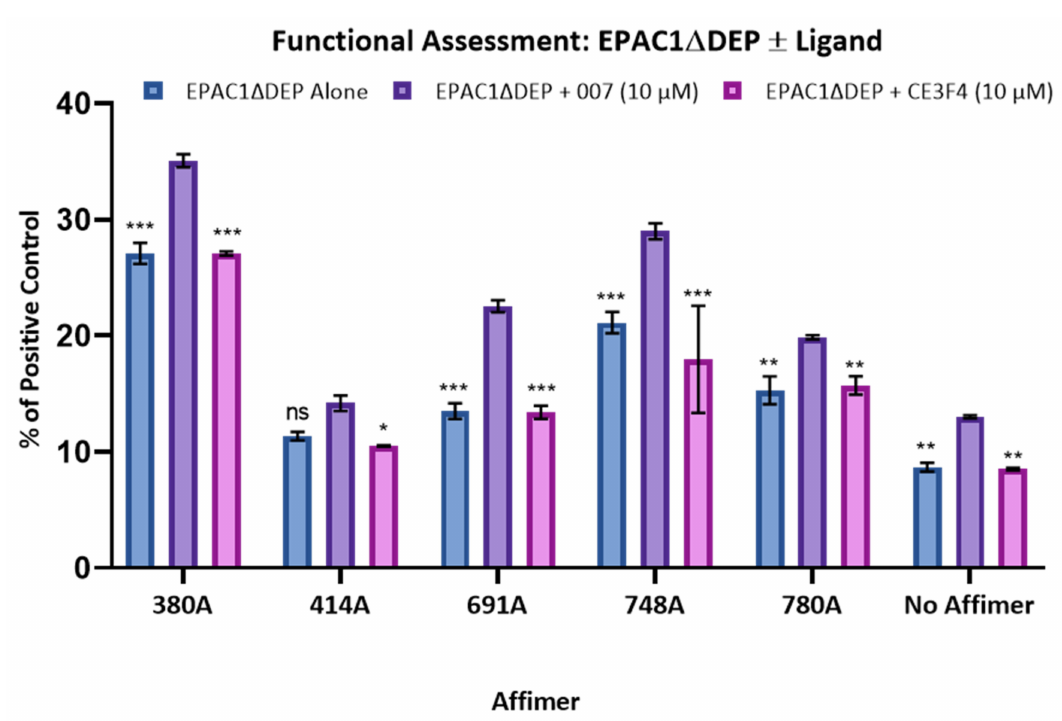
Figure 2. Assessment of Affimers binding to EPAC1 ∆ DEP in the presence or absence of agonist and antagonist. Affimer binding to biotinylated EPAC1 ∆ DEP protein was determined by iQue assay, in the presence and absence of 10 µ M 007 (EPAC1 agonist) or 10 µ M CE3F4 (EPAC1 antagonist). Data were normalized to the median fluorescent intensity of the positive control Affimer (Affimer G12 against immobilized mIgG2b), which was set to 100%. Significant increases in binding were determined by one-way ANOVA. Relative differences in binding relative to EPAC1 ∆ DEP plus 10 µ M 007, are indicated; * p < 0.05; ** p < 0.001 and *** p < 0.0001, respectively ( n = 3). Results are presented as the means ± SD ( n = 3). ns: Not